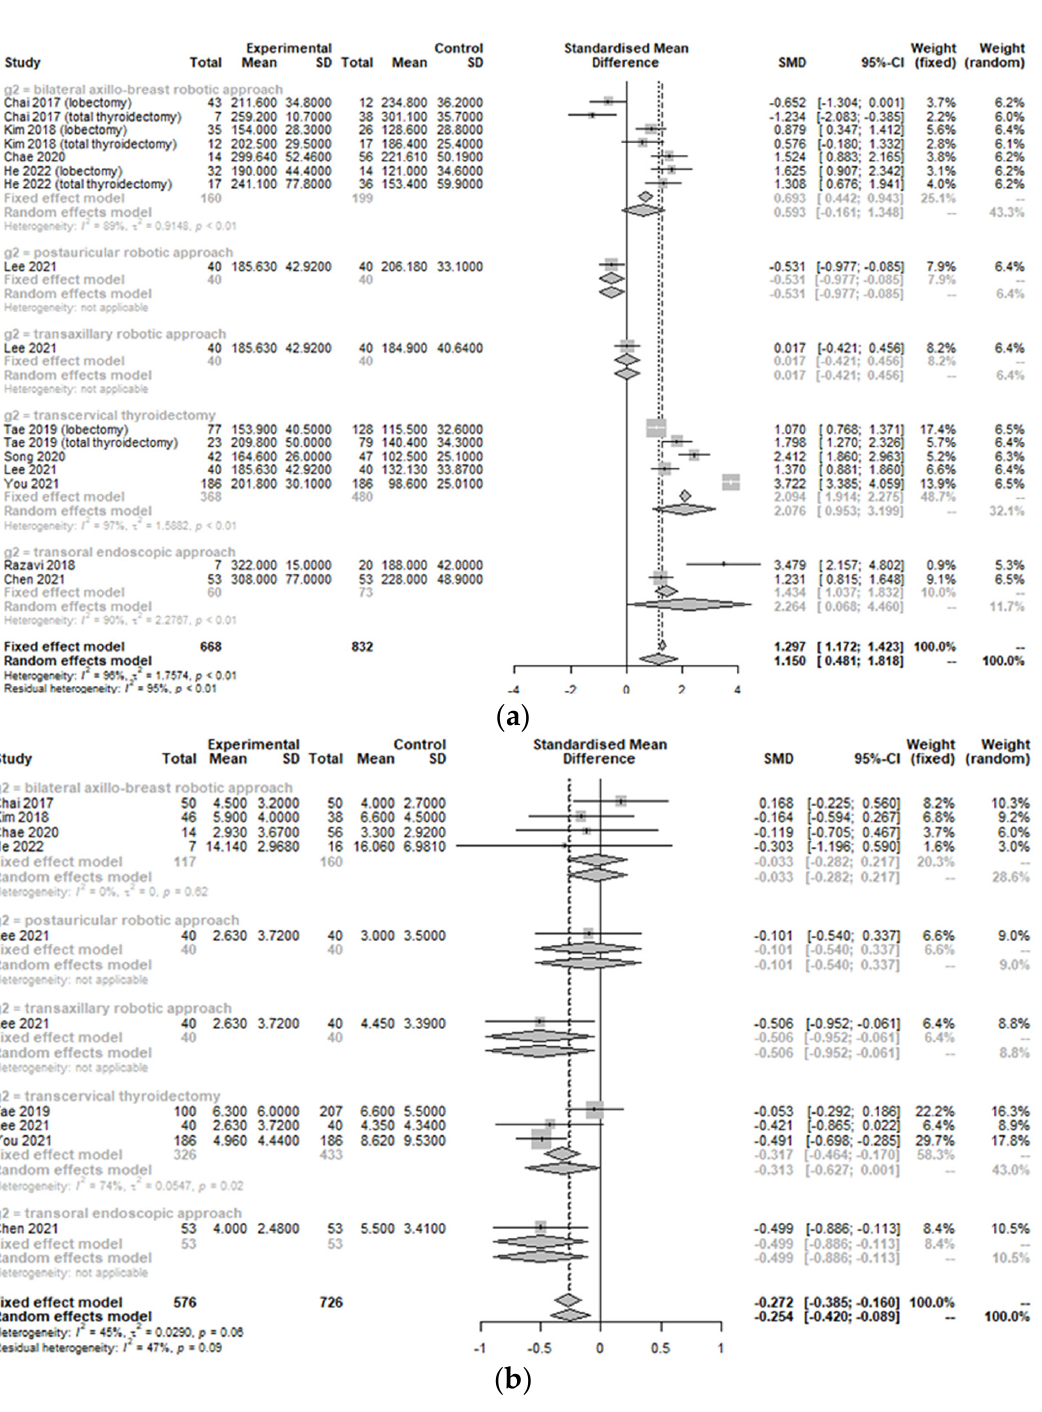
Figure 3. Forest plot for standard mean difference in operation-related outcomes (operative time ( a ) and retrieved lymph node number ( b )) (total: number of participants per group). Table 2. Subgroup analysis of operation-related measurements according to the comparison with other operative types.